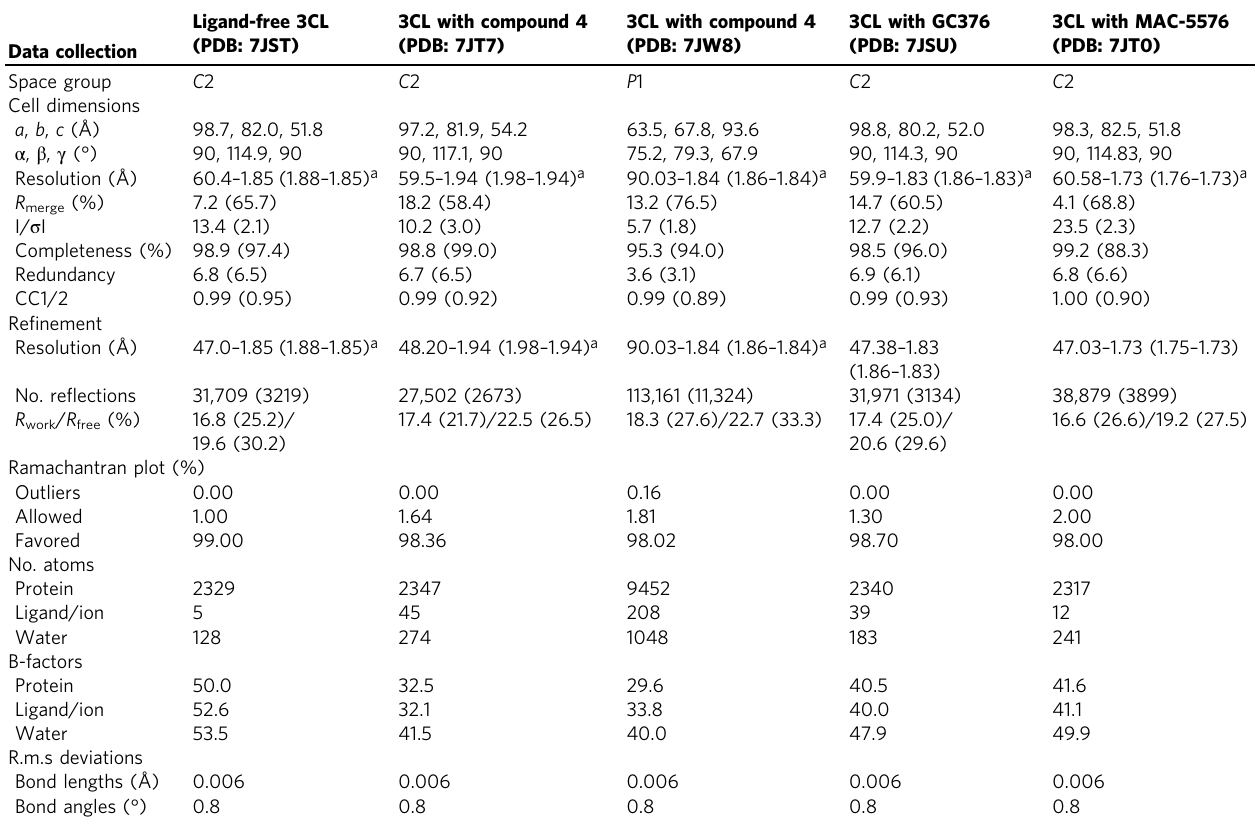
Table 1 Data collection and re fi nement statistics of ligand-free SARS-CoV-2 3CL protease and 3CL protease bound to compound 4, GC376, and MAC-5576. Ligand-free 3CL (PDB: